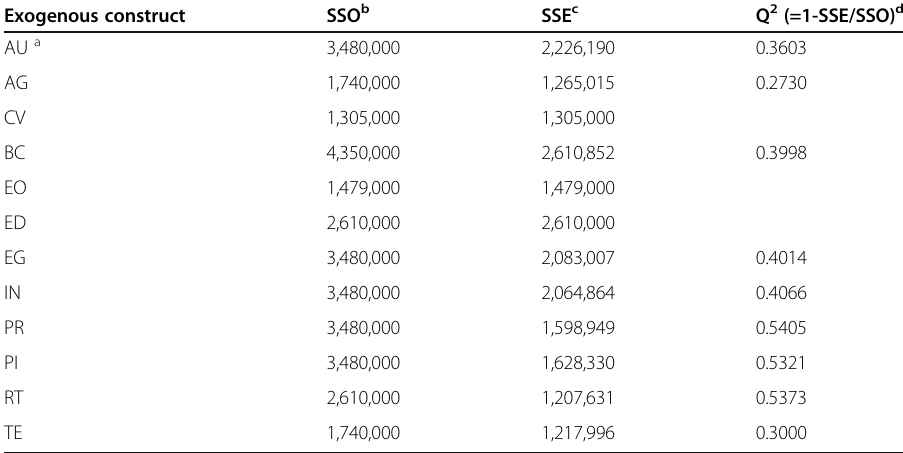
Table 8 PLS path model ’ s predictive